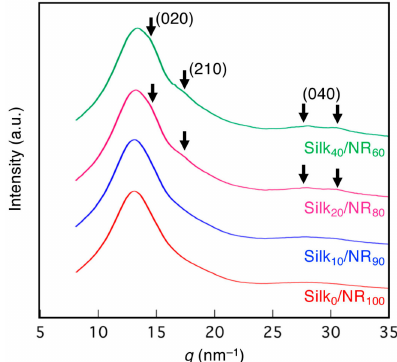
Figure 7. One-dimensional WAXD profiles of silk / NR composites with di ff erent silk contents. A broad amorphous halo peak was observed for Silk 0 / NR 100 and Silk 10 / NR 90 . The amorphous halo and the Bragg reflections (020) / (210) / (040) in silkworm silk from B. mori were observed for Silk 20 / NR 80 and Silk 40 / NR 60